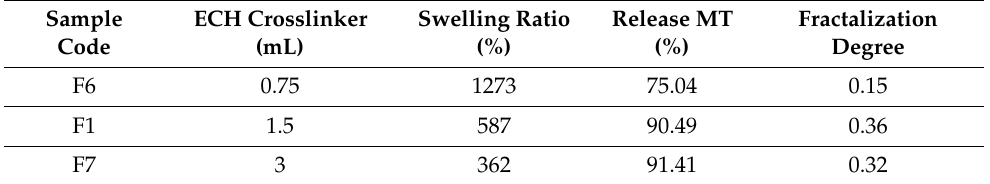
Table 6. Fractalization degree vs. crosslinker amount and released drug amount.